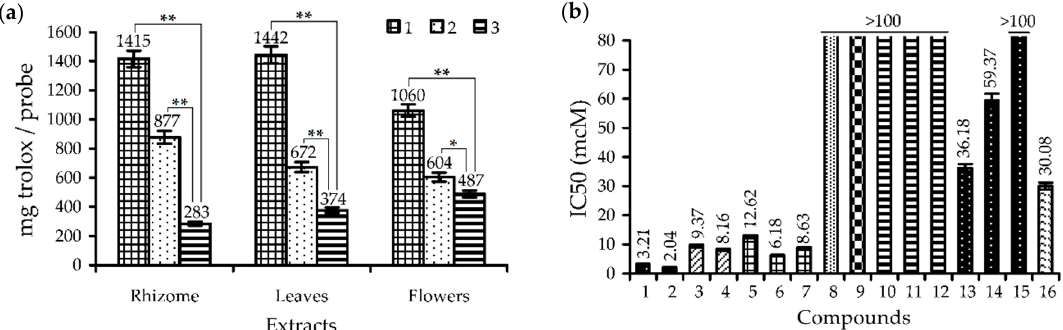
Figure 3. ( a ) Trolox-equivalent content in R. rosea extracts after in vitro treatment by the simulated gastric and intestinal media. * p < 0.05 vs. intestinal phase group; ** p < 0.001 vs. intestinal phase group. Groups: 1—initial group; 2—group after gastric phase; 3—group after intestinal phase. ( b ) Radical scavenging activity of selected compounds (as IC 50 , µ M). 1—1,6-di- O -galloyl glucose; 2—1,2,3,4,6- penta- O -galloyl glucose; 3—procyanidin B1 (as an example of procyanidin dimer); 4—procyanidin C1 (as an example of procyanidin trimer); 5—epicatechin; 6—epigallocatechin gallate; 7—